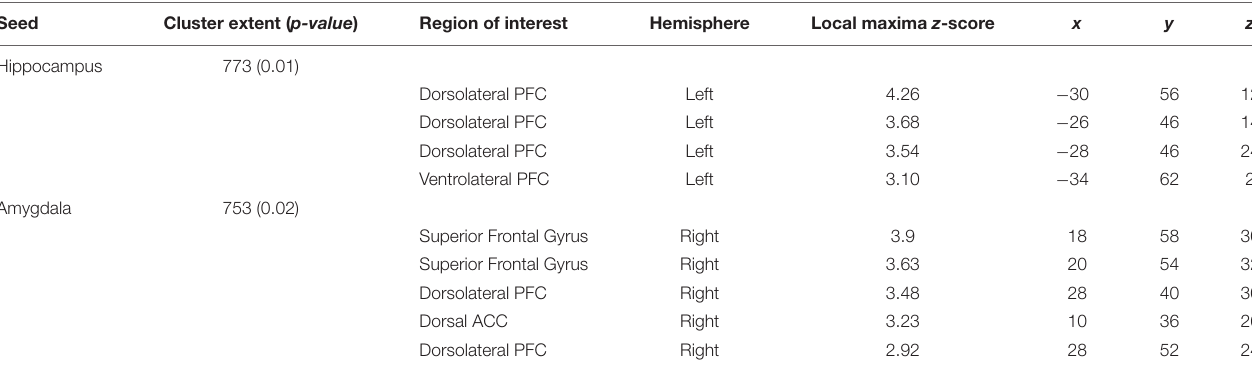
Regions met a cluster-defining threshold of z > 2.3 and p < 0.05. Cluster extent is in voxels. The first coordinate listed under each cluster describes the location of the highest local maximum within the cluster. Additional regions with local maxima within the same cluster are listed following the strongest local maximum for that